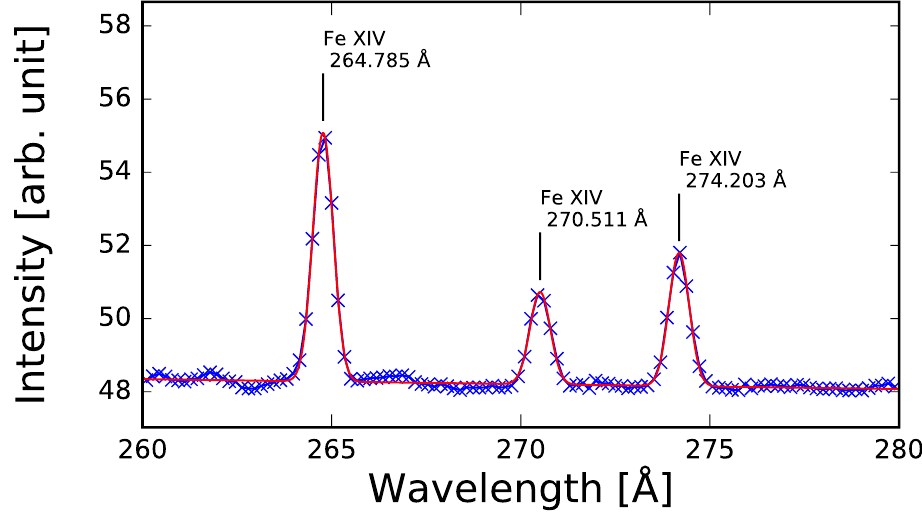
Figure 7. Spectra measured with CoBIT-II at NIFS. Filled circles are data points, and error bars indicate one sigma in Poisson distribution. Solid line shows fitted spectrum, and peaks correspond to lines of Fe XIV 264.785 Å, 270.511 Å, and 274.203 Å,